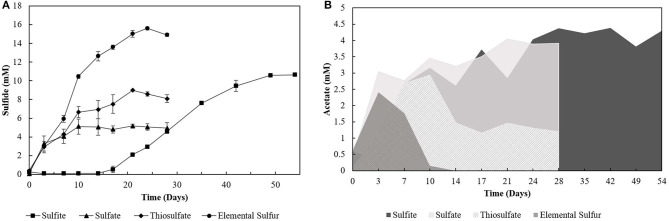
(A) Sulfide production and (B) acetate profile of the 4th transfer enrichments oxidizing oleate with sulfur compounds as electron acceptors. Measurements of biological triplicates were averaged, and the standard deviation is shown.